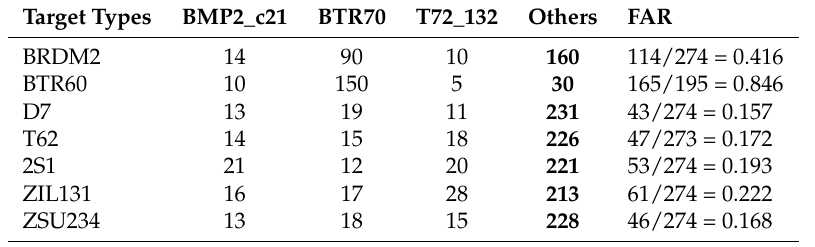
The number of “out-targets” HRRP sequences in the test set = 1838.